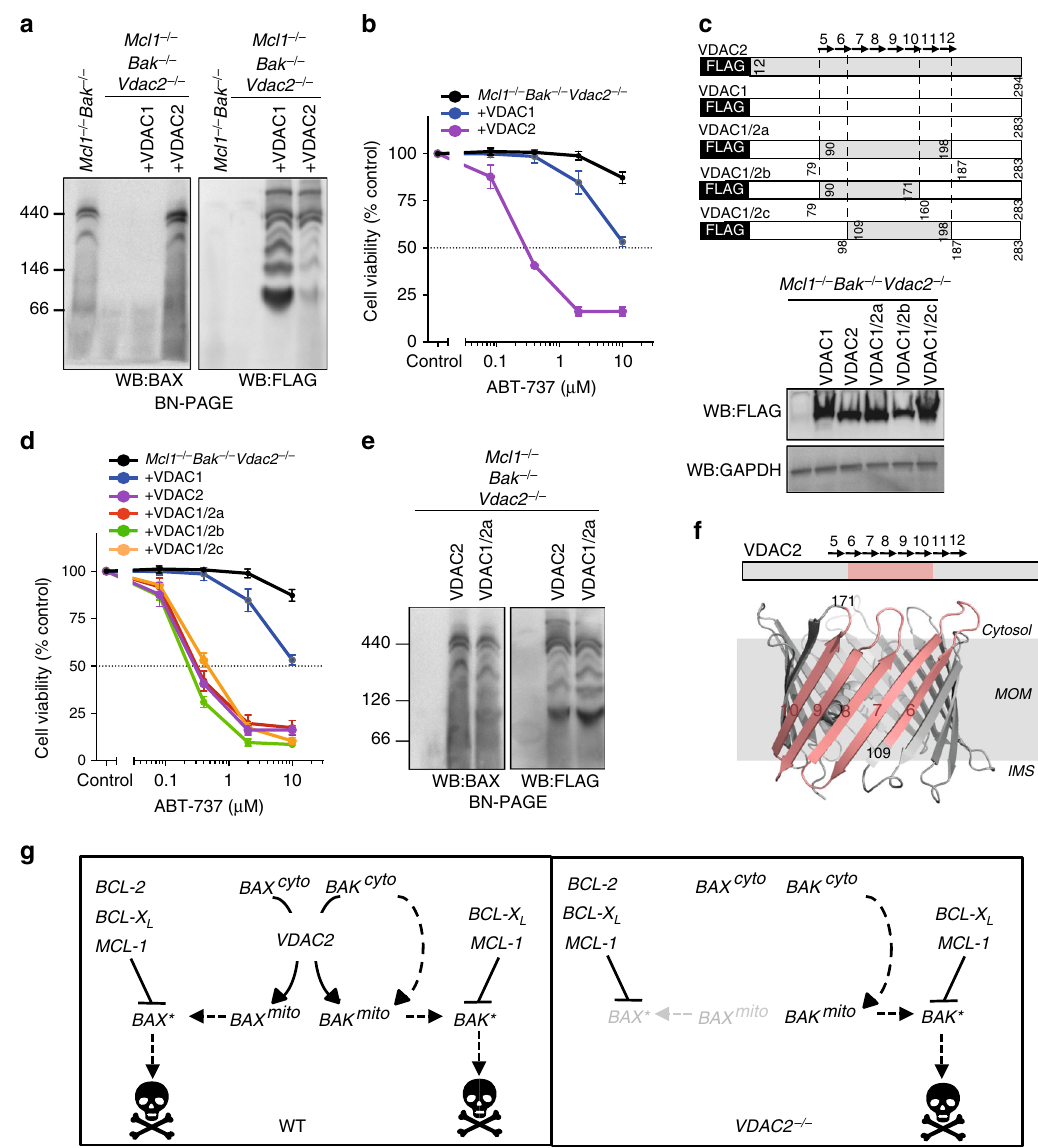
Fig. 3 Interaction with VDAC2 is important for BAX apoptotic function. a BAX mitochondrial complex formation speci fi cally relies on VDAC2. Mitochondria-enriched fractions from Mcl1 − / − Bak − / − Vdac2 − / − MEFs reconstituted with FLAG-mVDAC1 or FLAG-hVDAC2 were analyzed by BN-PAGE and immunoblotted for BAX (left) or FLAG to detect ectopically-expressed VDACs (right). b BAX apoptotic function relies on VDAC2. Cells as in ( a ) were treated with ABT-737 and cell viability was assessed. c – e Rescue of BAX apoptotic function correlates with interaction with a speci fi c region of VDAC2. Mcl1 − / − Bak − / − Vdac2 − / − MEFs stably expressing FLAG-mVDAC1/hVDAC2 chimeras ( c ) were analyzed for expression by immunoblotting for FLAG (or GAPDH as a loading control), cell viability following treatment with ABT-737 ( d ), and complex formation by BN-PAGE and immunoblotting for BAX or FLAG ( e ). f BAX interacts with a de fi ned region of VDAC2. Interaction of BAX requires aa109-171 of hVDAC2 (salmon) mapped onto the structure of zebra fi sh VDAC2 (PDB 4BUM 64 ). MOM mitochondrial outer membrane, IMS intermembrane space. g VDAC2 is essential for BAX, but not BAK to target mitochondria and mediate apoptosis. In wild-type cells, cytosolic BAX (BAX cyto ) relies on VDAC2 to associate with mitochondria (BAX mito ) and activate (BAX*). In the absence of VDAC2, BAX cannot drive cell death. Although the ability of BAK to associate with mitochondria is also perturbed in VDAC2 − / − cells 14, 31 , suf fi cient BAK can still target mitochondria through a VDAC2-independent mechanism to drive apoptosis. Data presented in ( b ) and ( d ) is mean + / − SEM of three independent